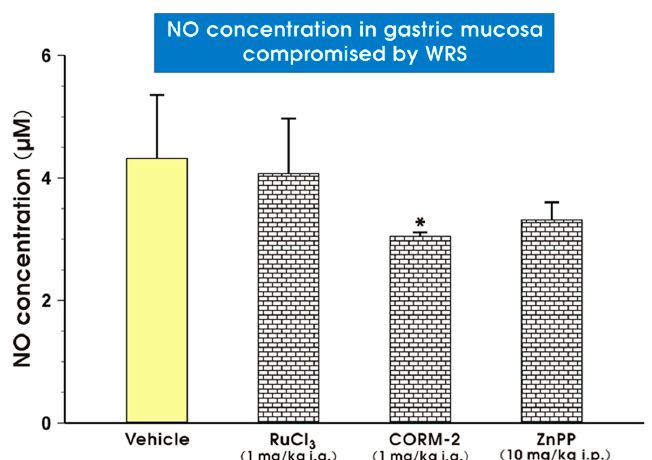
Figure 8. The gastric mucosal nitric oxide (NO) content in rats pretreated i.g. with vehicle (saline; yellow pattern), RuCl 3 (1 mg/kg; brick pattern), carbon monoxide releasing molecule 2 (CORM-2, 1 mg/kg; brick pattern) or zinc protoporphyrin IX (ZnPP, 10 mg/kg i.p.; brick pattern) and exposed 30 min later to 3.5 h of water immersion and restraint stress (WRS). Results are mean ± S.D. of 4–5 animals in each experimental group. Asterisk indicates significant change ( p < 0.05) as compared with vehicle-treated control group.